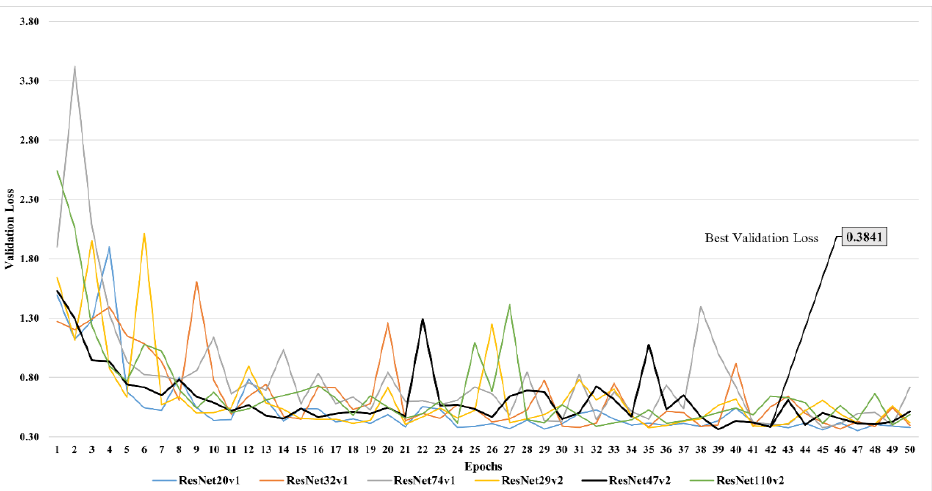
Figure 15. Validation loss curves for various ResNet models.